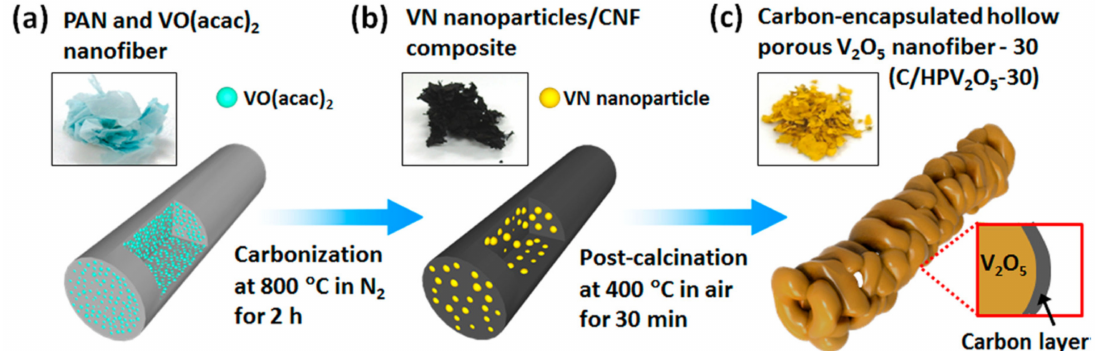
Figure18. SchematicofsynthesizingV 2 O 5 hollowporousfiber: ( a )electrospinningprecursornanofibers, ( b ) VN nanoparticles / CNF composite made by carbonization, ( c ) calcination. Reprinted with permission from [137]. Copyright © 2016 America Chemical